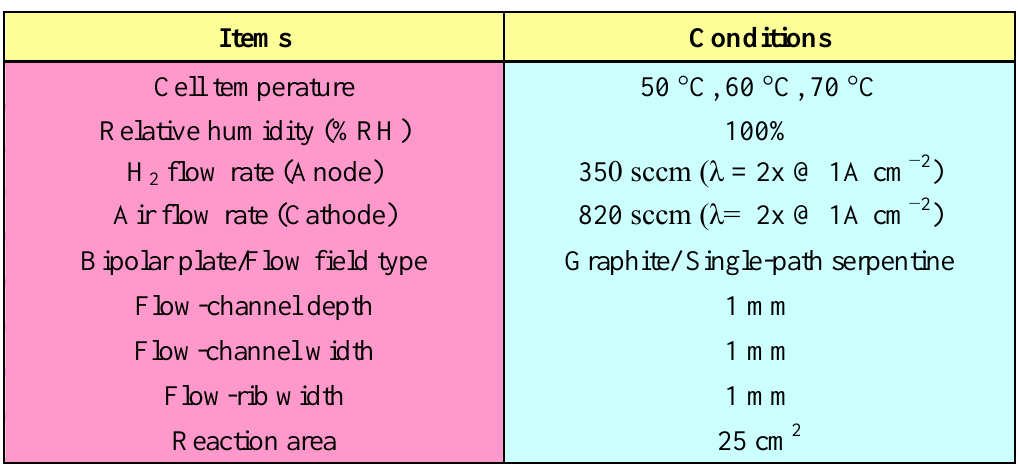
Table 2. Operating conditions.